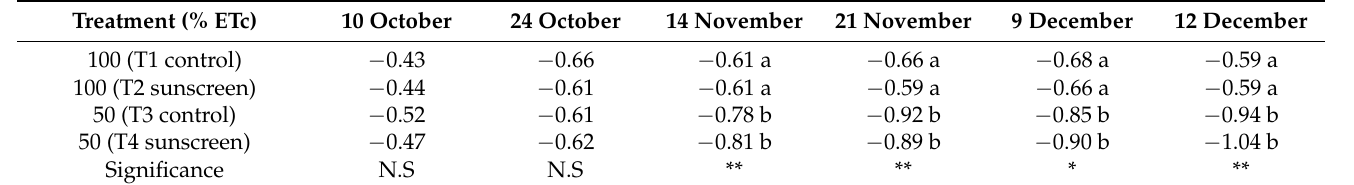
Table 3. Stem water potential (MPa) measured in the performed treatments on ‘Duke’ along the season.